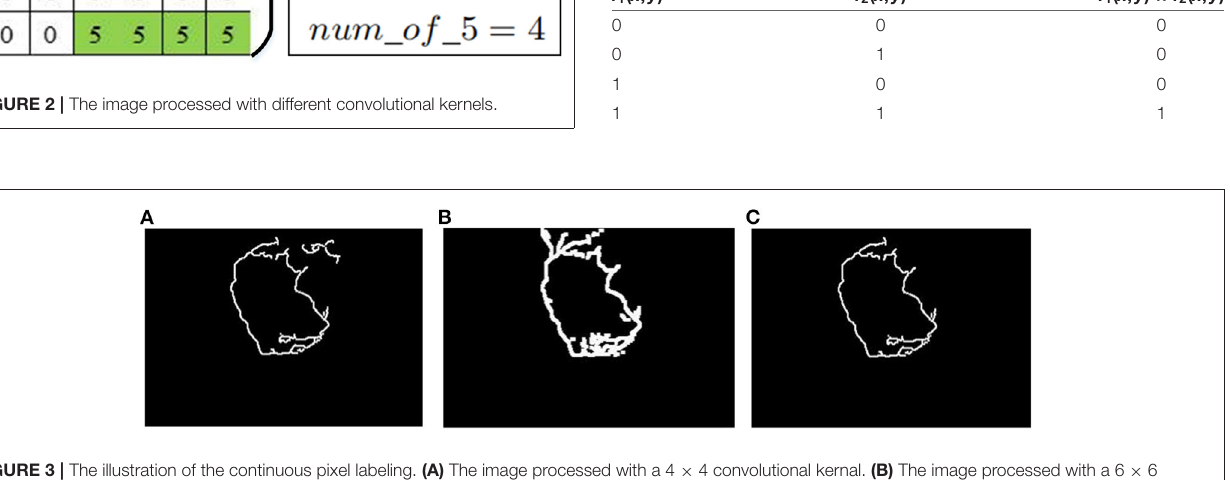
Frontiers in Neurorobotics |